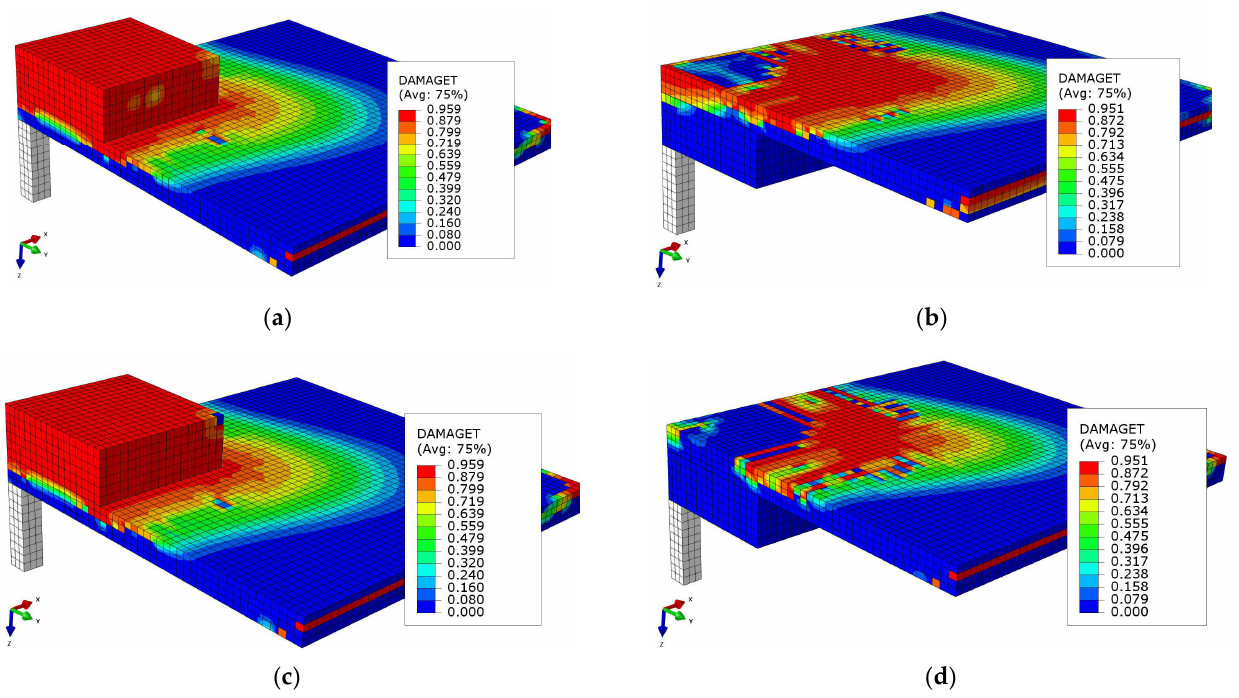
Figure 14. Tensile damage diagrams of tensile sides of specimens ZM01–ZM04 at yield load: ( a )